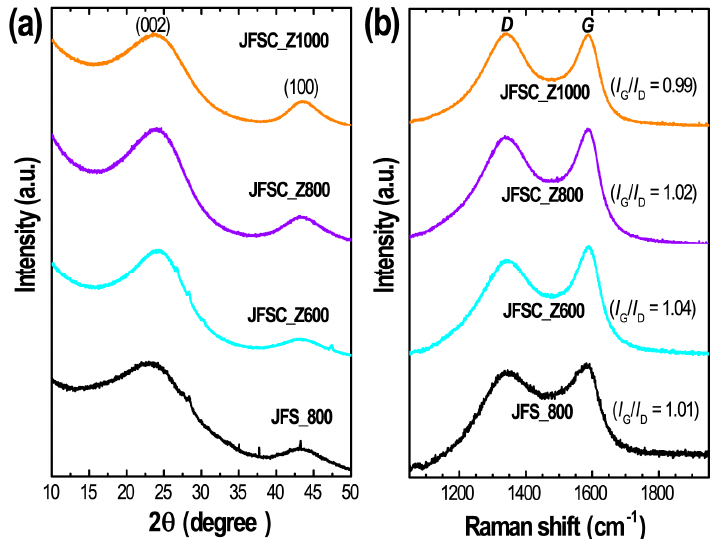
Figure 2. ( a ) The pXRD patterns of JFS_800, JFSC_Z600, JFSC_Z800 and JFSC_Z1000 measured at